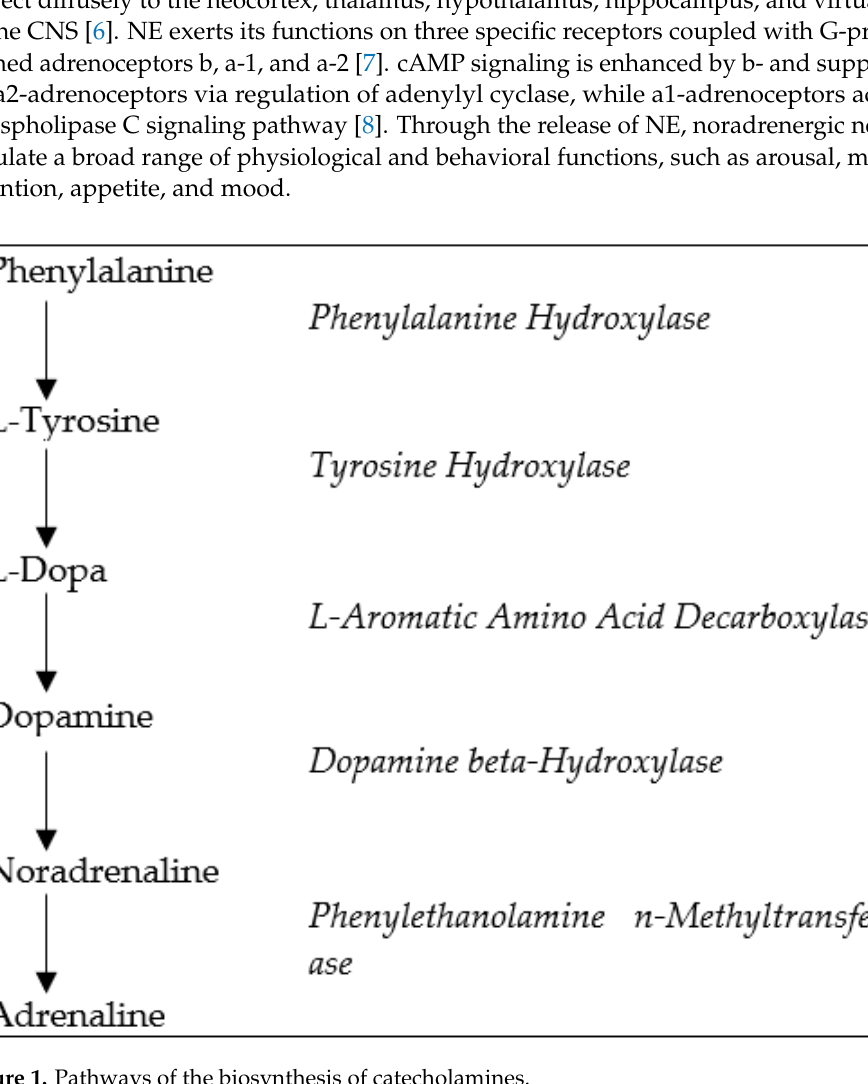
Figure 1. Pathways of the biosynthesis of catecholamines.